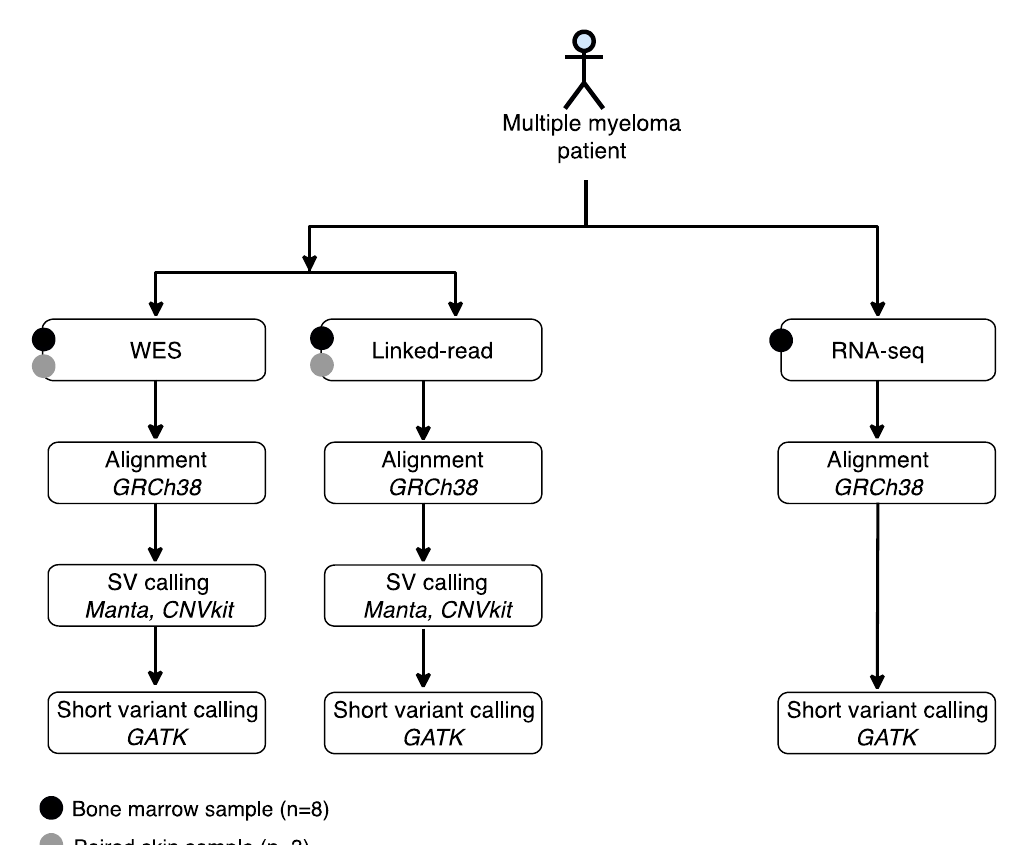
Figure 1. Experimental design and data analysis workflow of the study. Bone marrow aspirates were collected from eight multiple myeloma patient samples and three matched skin controls, followed by plasma cell (CD138+) isolation. Matched skin controls were collected from three patients. DNA and/or RNA were isolated and used for linked-read, whole-exome and/or RNA sequencing. The Manta SV caller and CNVkit were used to detect structural variants and the GATK variant calling pipeline was used to detect short variants.